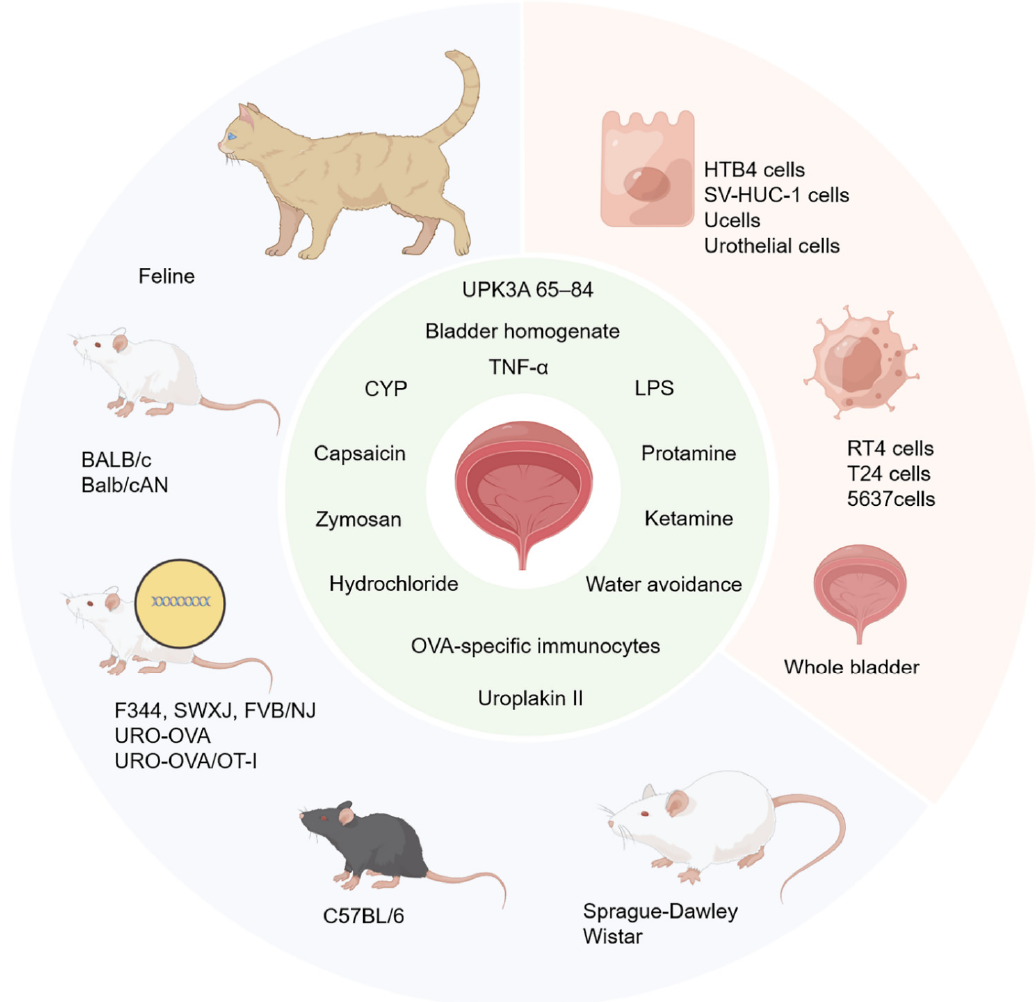
Figure 3. Animal and cell models related to IC/BPS. Feline, mice (including BALB/c and Balb/cAN), transgenic mice (F344, SWXJ, FVB/NJ, URO-OVA and URO-OVA/OT-1), rats (C57BL/6), and transgenic rats (Sprague-Dawley and Wistar) are the animal models related to IC/BPS. Urothelial cell lines (HTB4 cells, SV-HUC-1 cells, Ucells and Urothelial cells) and cancer cell lines (RT4 cells, T24 cells and 5637 cells) and the whole bladder are the cell models related to IC/BPS. UPK3A 65–84, bladder homogenate, CYP, LPS, TNF- α , capsaicin, zymosan, hydrochloride, protamine, ketamine, water avoidance, OVA-specific immunocytes, and Uroplakin II are the stimulants which can induce IC/BPS in animals and cells. CYP, cyclophosphamide; LPS, lipopolysaccharide; TNF- α , tumor necrosis factor-alpha.